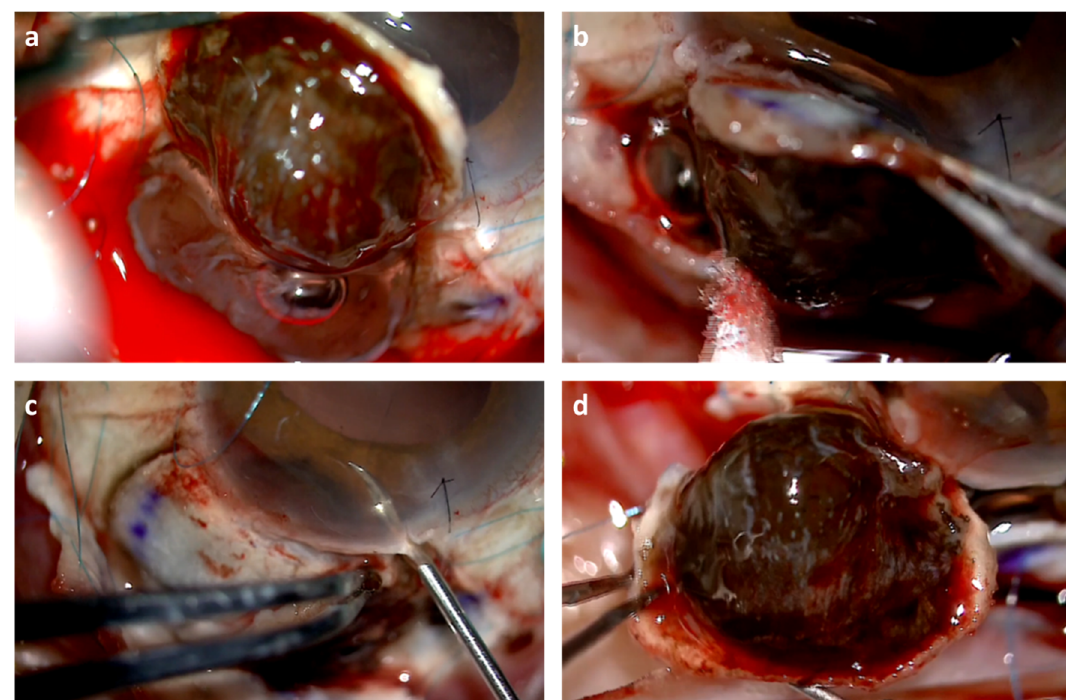
Figure 3. Exoresection procedure showing: ( a ) exoresection keeping the hyaloid intact; ( b ) closing the flap before tumor resection: the bubble can be seen that indicates that the hyaloid is still intact; ( c ) anterior resection with microscissors; ( d ) resection of complete specimen.